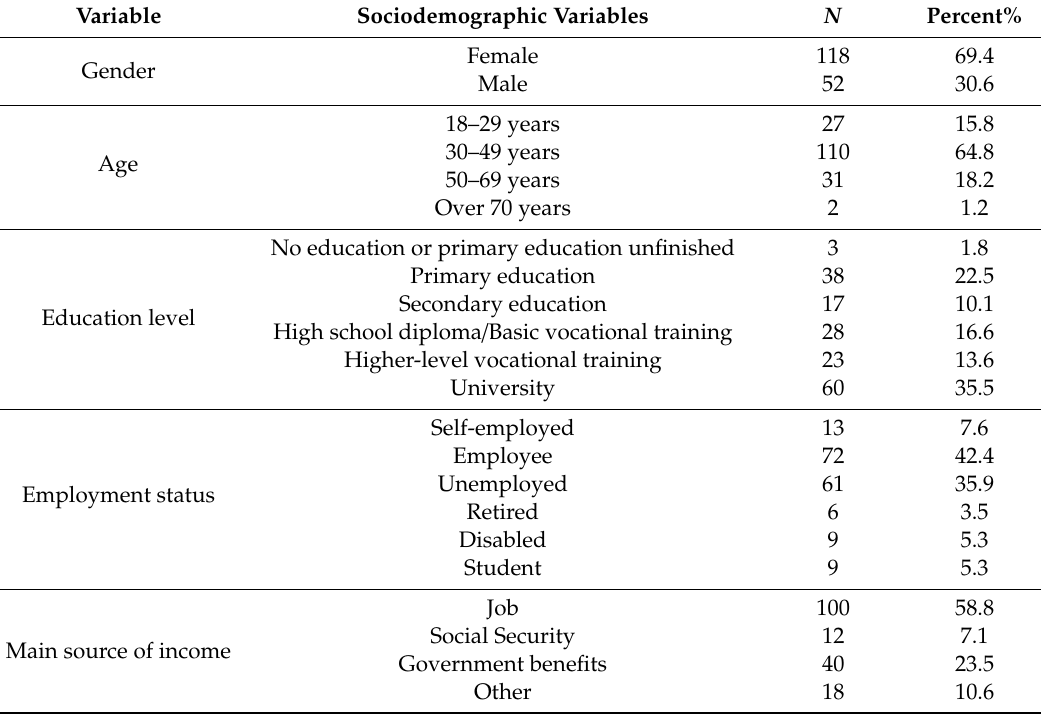
Table 1. Description of the study sample. Sociodemographic